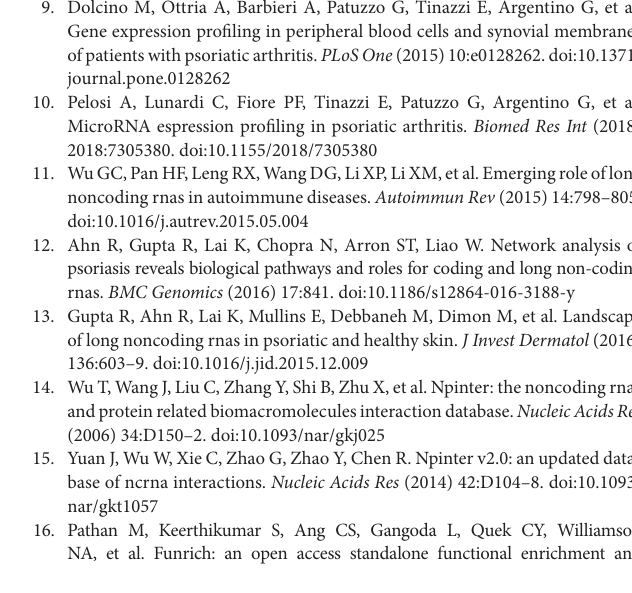
TaBle s6 | Long non-coding RNAs modulated in psoriatic arthritis that target modules. FigUre s1 | Expression of selected long non-coding RNAs in psoriatic arthritis (PsA) patients by real-time PCR. Real-time PCR of LUCAT1 and lnc-TRIM55-1 in PsA and healthy samples included in the microarray. Bars indicate SD. * p < 0.05; ** p < 0.01; Student t -test. FigUre s2 | Expression by real-time PCR of genes involved in signaling pathways that are modulated in psoriatic arthritis patients compared to healthy subjects. Bars indicate